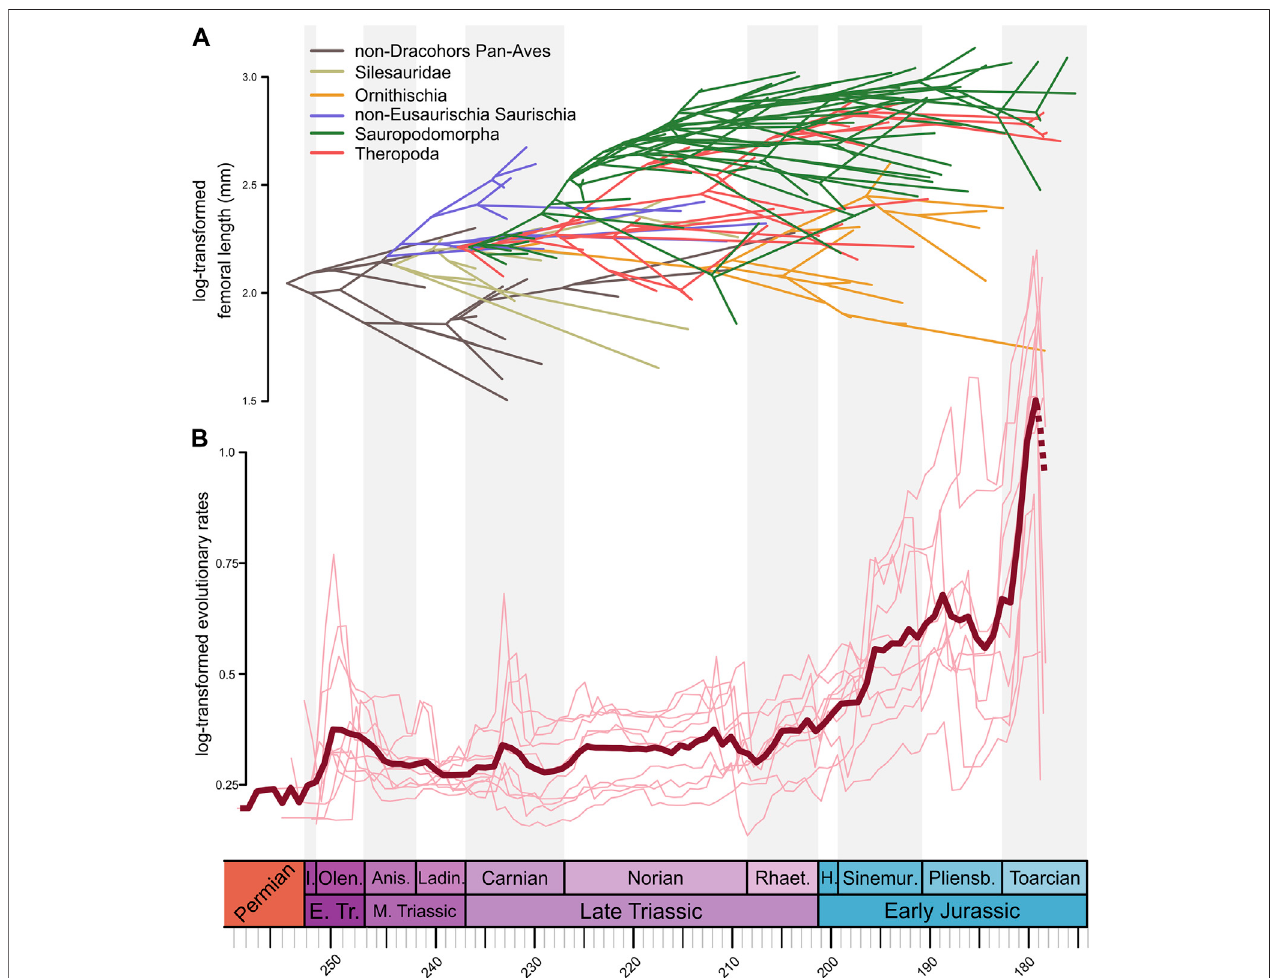
FIGURE 5 | (A) Phenogram of Triassic to Early Jurassic Pan-Aves (excluding pterosaurs) with body size incorporated (i.e., log-transformed femoral length in millimeters). Phylogeneticrelationships displayed asin oursupertreeST 1(silesaurids externaltoDinosauria, theropods forming Saurischia withsauropodomorphs, and herrerasaurs external to Eusaurischia). (B) Through-time rates of body size evolution (log-transformed relative evolutionary rate scalar) of terrestrial Pan-Aves estimated using a heterogeneous rates (or variable rates) model in BayesTraits. Light red lines represent values for each of the ten trees from the ST 1 with “ ghost lineages. ” Dark red line represents mean rate values (mean scalar) from all ten trees. Dashed red line represents the uncertainty of patterns through the Toarcian from a possible “ edge effect. ” Timescale abbreviations: as in Figure 1 .